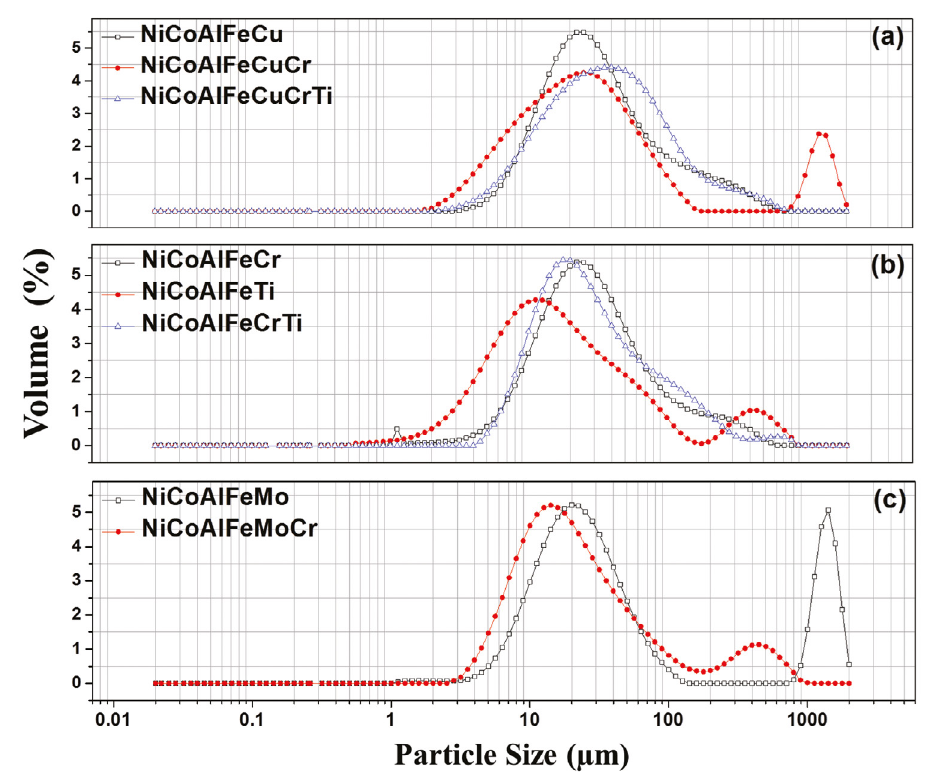
Figure 7: Particle size distribution curves of powders milled for 10 h, as a function of chemical